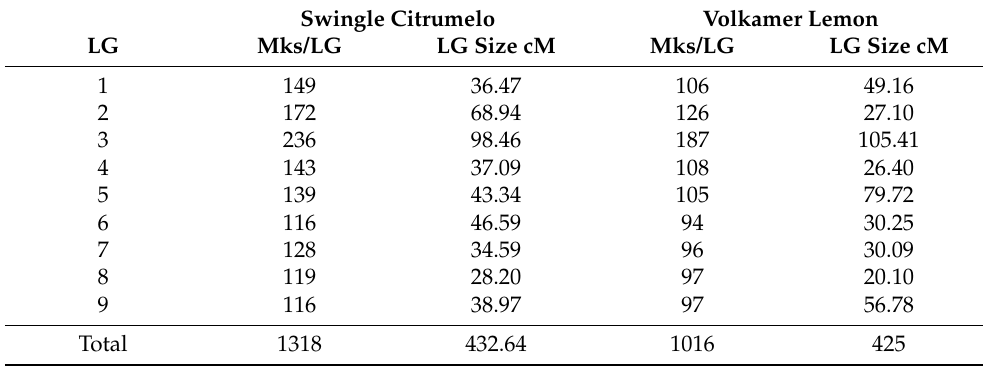
Table 2. Summary of tetraploid Swingle citrumelo and tetraploid Volkamer lemon genetic maps.